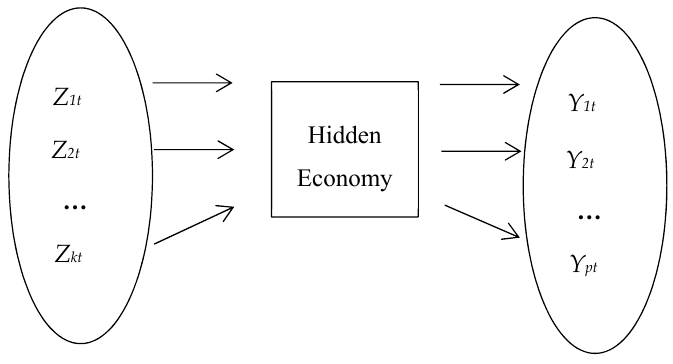
Figure 1. A Multiple Indicators Multiple Causes